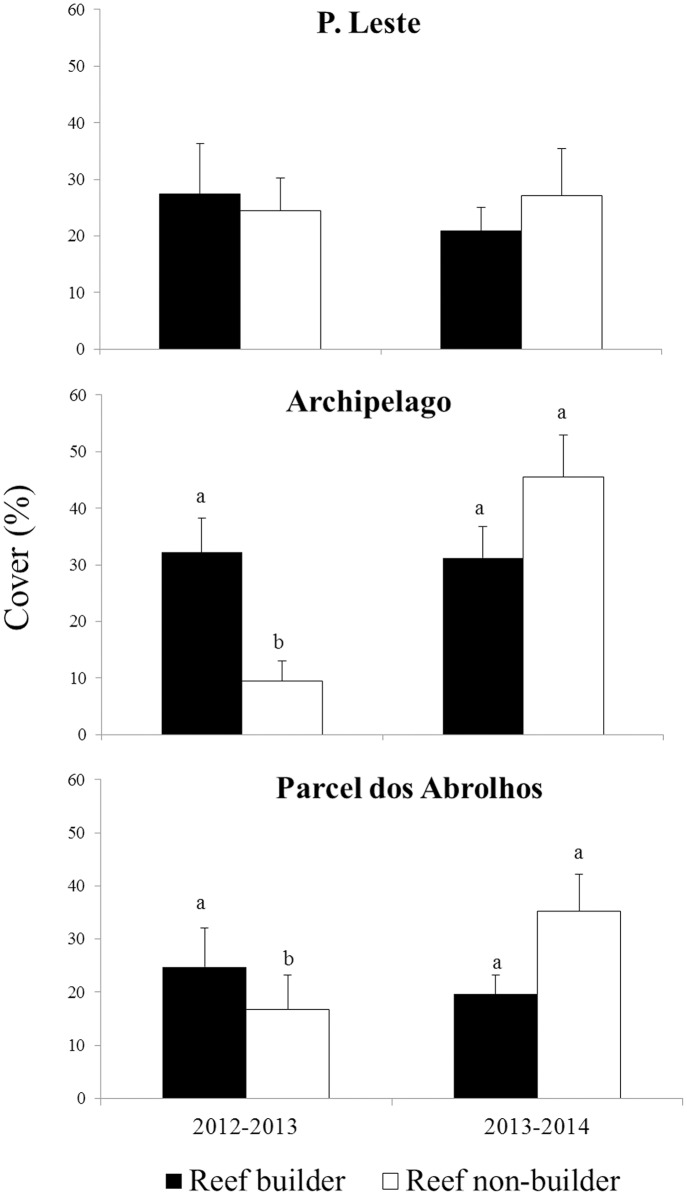
Abundance of reef-builder and non-builder organisms on shallow reefs (P. Leste, Archipelago and P. Abrolhos) after one year of colonization.Different letters above bars are used to indicate statistically differences (p< 0.05) of cover of organisms obtained through pair-wise tested after the PERMANOVA analysis.